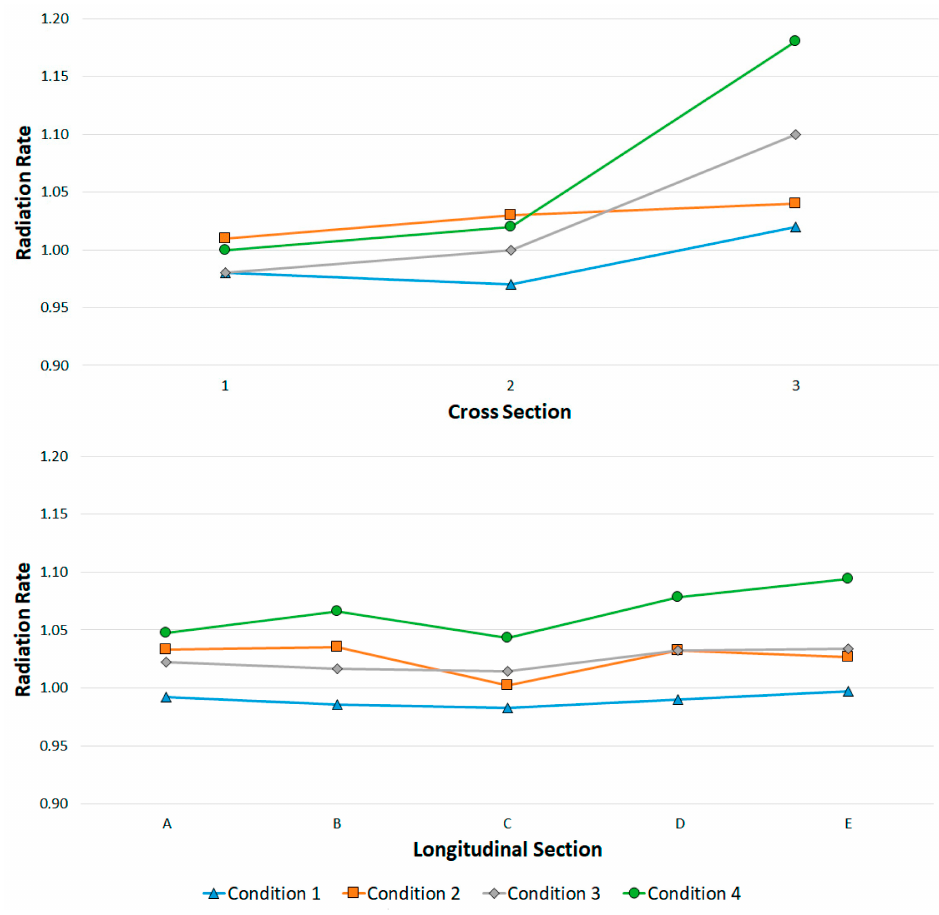
Figure 7. Plot of average radiation ratio distributions.